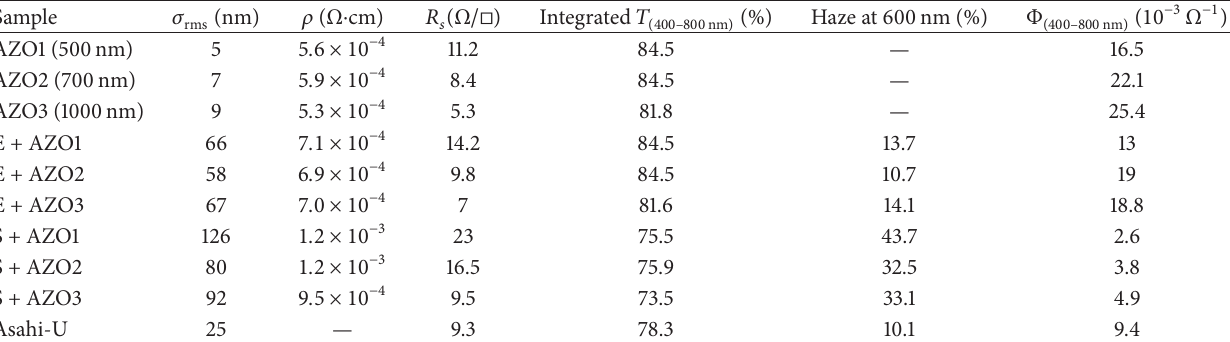
Table 1: Surface roughness ( 𝜎 ), resistivity ( 𝜌 ), sheet resistance ( 𝑅 𝑠 ), integrated transmittance 𝑇 (400–800 nm), haze at 600 nm, and figure rms of merit values ( Φ ) of the AZO layers deposited on smooth and textured glass along with that of Asahi-U substrate.